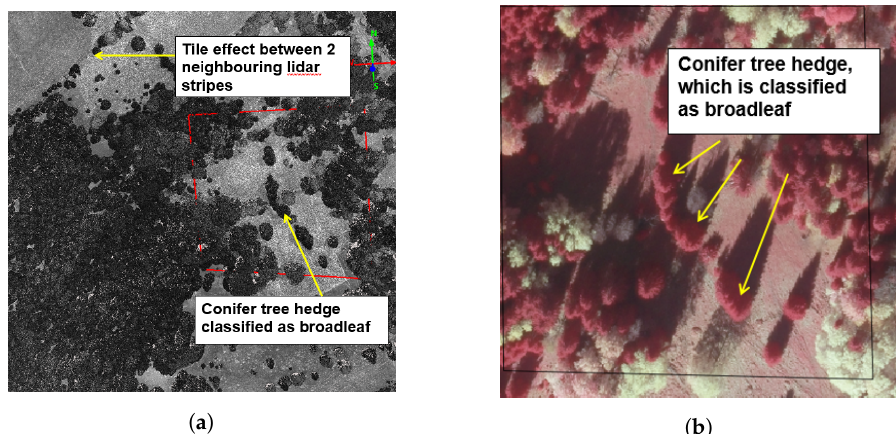
Figure 6. Intensity issues in the mixed forest area. ( a ) Tile effect between neighboring laser strips ( b ) Mis-classified broadleaf trees. Table 12. Results for the classification of conifers and broadleaf trees. Bavarian Forest National Park: Test data are from reference areas HTO and C 1: 1637 conifers and 636 broadleaf trees for training. 722 conifers, 253 broadleaf trees for testing (=Reference #1). 293 conifers, 236 broadleaf trees for testing (=Reference #2 only from HTO ).